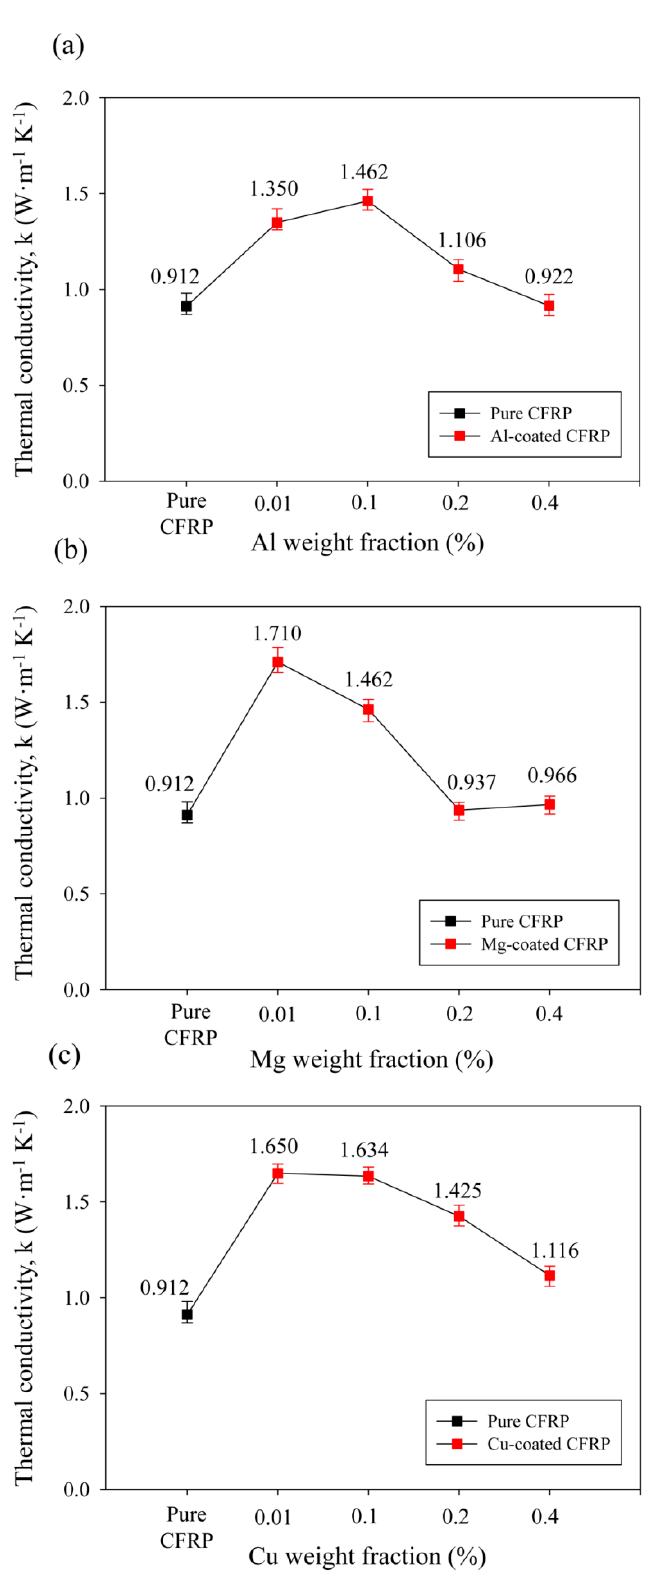
Figure 4. Through-thickness thermal conductivity of CFRP composites coated with three types of inorganic crystal fillers against the filler weight fraction: ( a ) aluminum; ( b ) magnesium; ( c ) copper.